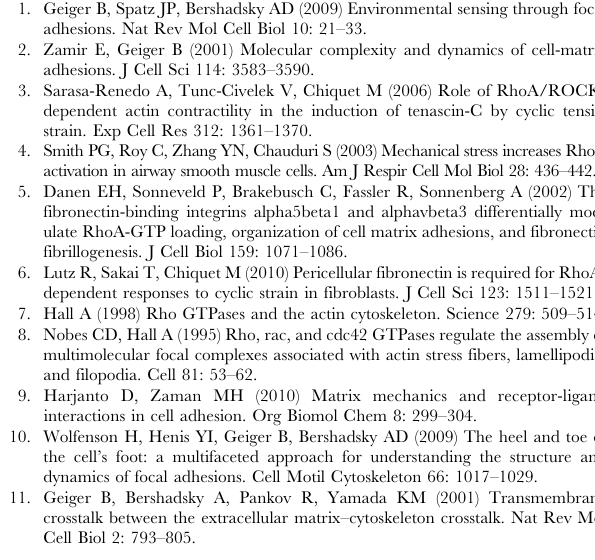
Figure S1 Control experiment for RGD functionaliza- tion of gold patterns. 1000 nm gold patterns were coupled with either RGD peptide alone (pure RGD), control peptide alone (pure RDG control), or mixtures of RGD:control peptide of 1:1, 1:4 and 1:9, respectively (total peptide concentration 3 mg/ml in all cases). Fibroblasts were plated, fixed and stained for F-actin as described in Materials and Methods. Note that cells spread fully on the coated gold patterns up to a RGD:control peptide ratio of